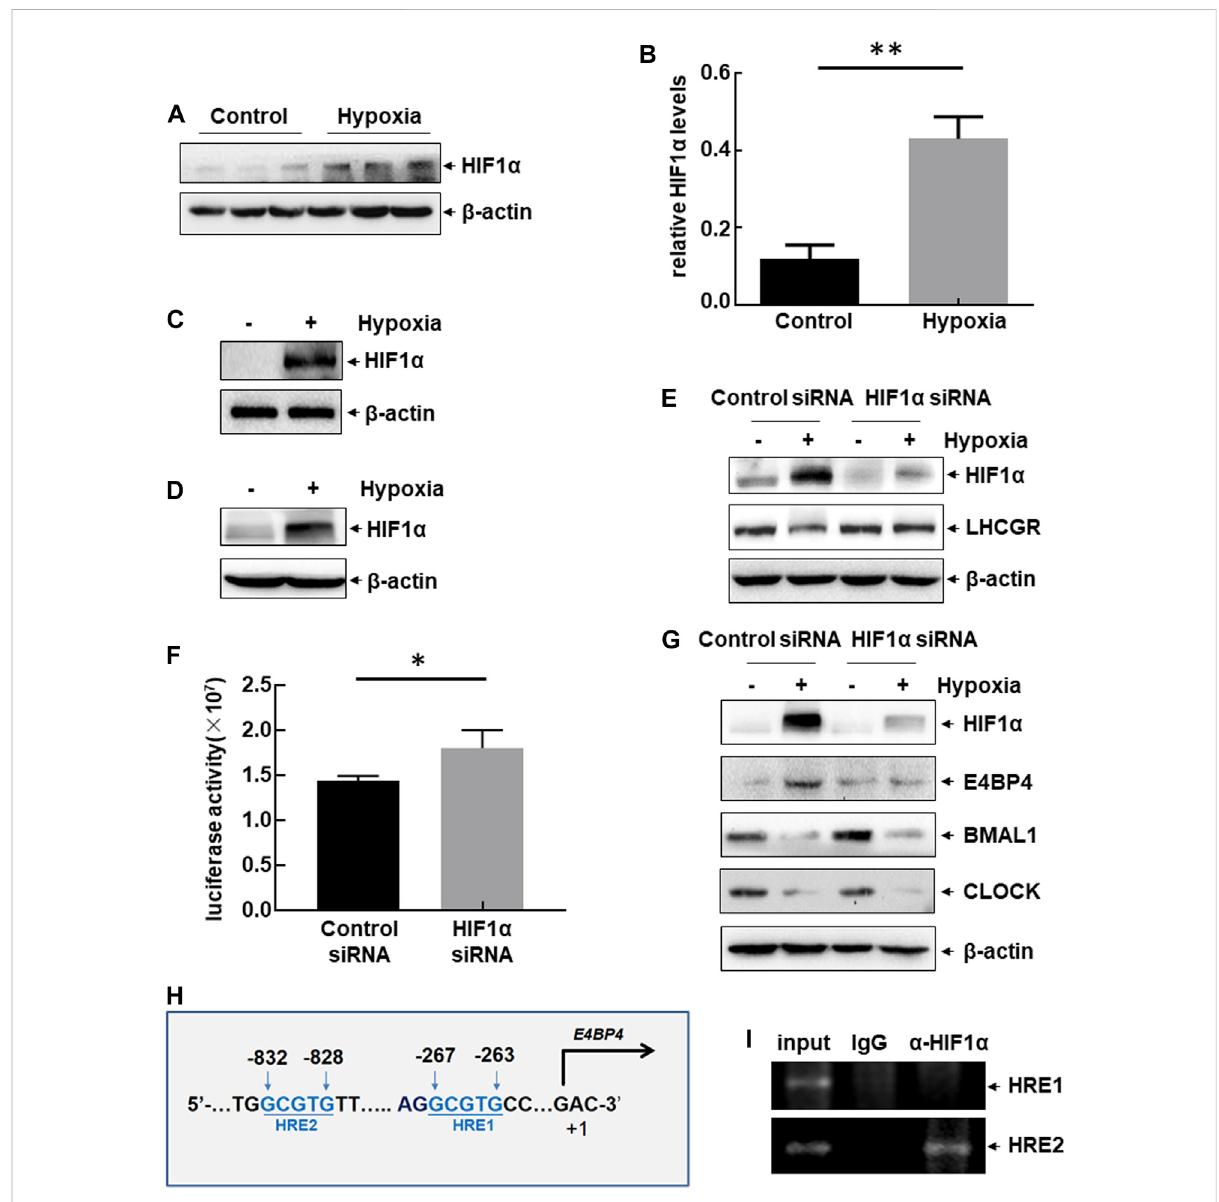
FIGURE 5 Hypoxia-induced dysregulation of clock-controlled LHCGR reduction in HIF1 ɑ -dependent and ɑ -independent manners. (A – B) Female mice were treated as shown in Figure 1A. Ovaries were collected 48 h after hypoxic exposure, and the expression level of HIF1 ɑ was detected. The quantitative results of HIF1 ɑ expression (relative to β -actin) are shown (B) ( n = 6, ** p < 0.01). (C – D) Primary GCs (C) and KK1 cells (D) were cultured under normoxic or hypoxic conditions for 6 h. Then, the expression level of HIF1 ɑ was detected. (E) Primary GCs were transfected with HIF1 ɑ siRNAorcontrolsiRNAandthenleftuntreatedorsubjectedtohypoxicexposure.Cellswerecollected6 hlater,andtheexpressionlevelofHIF1 ɑ was detected. (F) KK1 cells were transfected with the LHCGR promoter-driven luciferase reporter in combination with siRNA targeting HIF1 ɑ or control siRNA. The luciferase activitywas detected 36 hafter transfection (* p < 0.05). (G) Primary GCs weretransfectedand treatedas described for (E) , and the expression levels of circadian clock proteins were detected. (H) Potential HIF1 ɑ -binding sites (HRE) were identi fi ed within mouse E4BP4 promoter regions. (I) ChIP assays were performed on the hypoxia-treated KK1 cells to detect the functional HRE within the mouse E4BP4 promoter